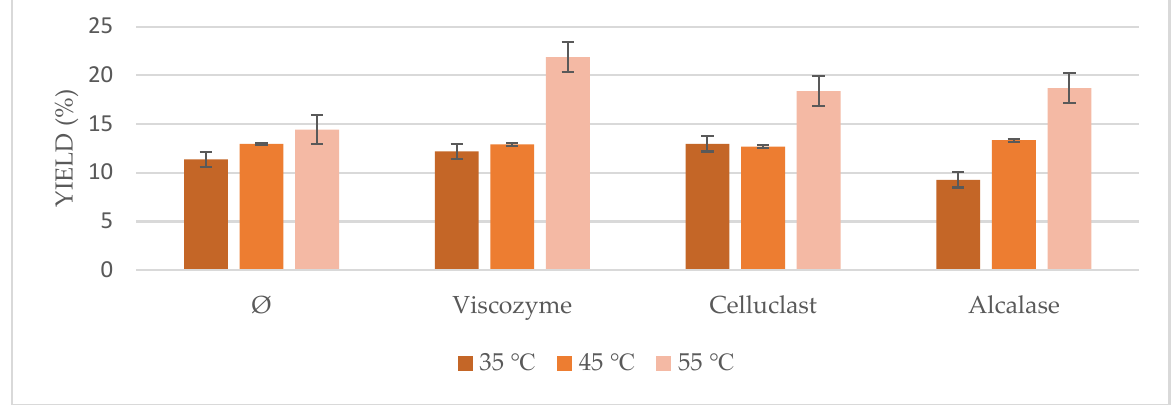
Figure 5. Nannochloropsis gaditana oil yields obtained by ultrasound-assisted enzymatic pretreatment at different tempera- tures (35, 45, and 55 °C).